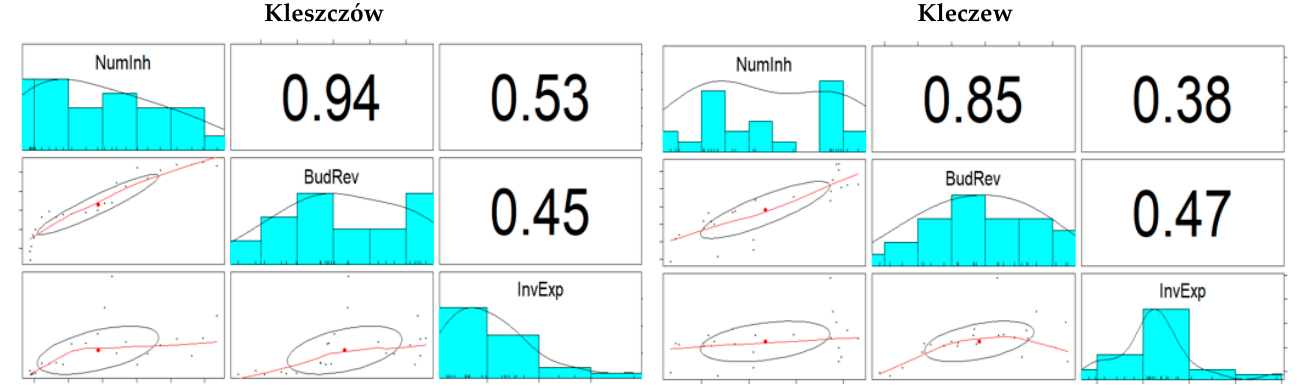
Figure 15. Pairwise correlations for the number of inhabitants ( NumInh ), budget revenues ( BudRev ) and investment expenditure ( InvExp ) (source: own elaboration in R Studio).